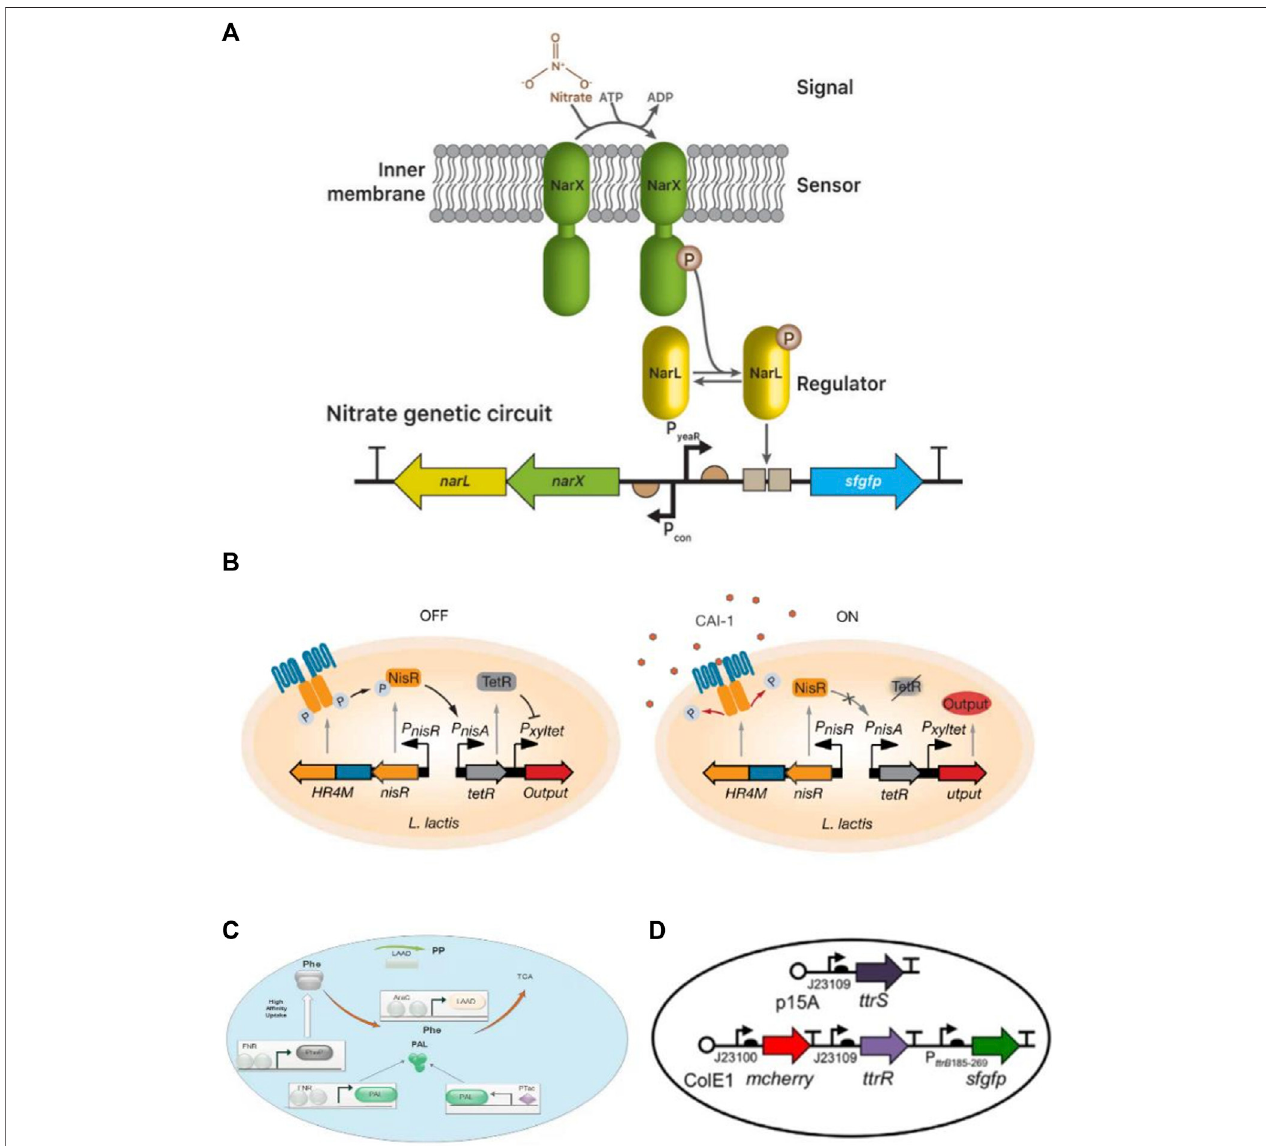
FIGURE 3 | Biodiagnostic applications of engineered bacteria. (A) A nitrate sensing genetic circuit consists of a two-component system NarX and NarL. In nitrate presence, both become phosphorylated and drive the expression of superfolder green fl uorescence proteins (sfgfp) reporter through a promoter. Reproduced with permission from Woo et al. (2020), Copyright 2020, Elsevier. (B) Vibrio cholera sensing device based on sensing module HR4M-NisR and processing module TetR/ Pxyltet make a complete circuit. In the presence of CAI-1, phosphorelay prevents HR4M-NisR and reduces TetR expression generate output by the activation of the gene. Reproduced with permission from Mao et al. (2018), Copyright 2018, American Association for the Advancement of Science. (C) A therapeutic strain SYNB1618consistsofageneforPhePencoding.PhePshowsahighaf fi nitytowardsPhetransporterthattransportsPheintothecellandconvertsintoTCA. (D) Plasmid design construction for the constitutive sensor in E. coli Nissle. Reproduced with permission from Daef fl er et al. (2017), Copyright 2017, John Wiley and Sons.